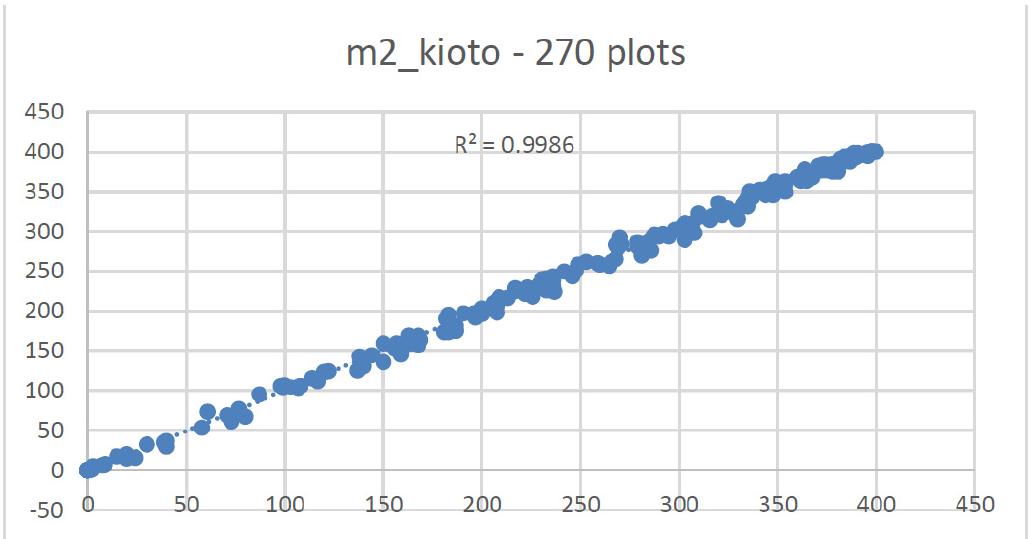
Figure A11. Reference area compared to estimated forest area by Method 1 for test plots (10 × 10 m 2 ) as defined by the UNFCCC.